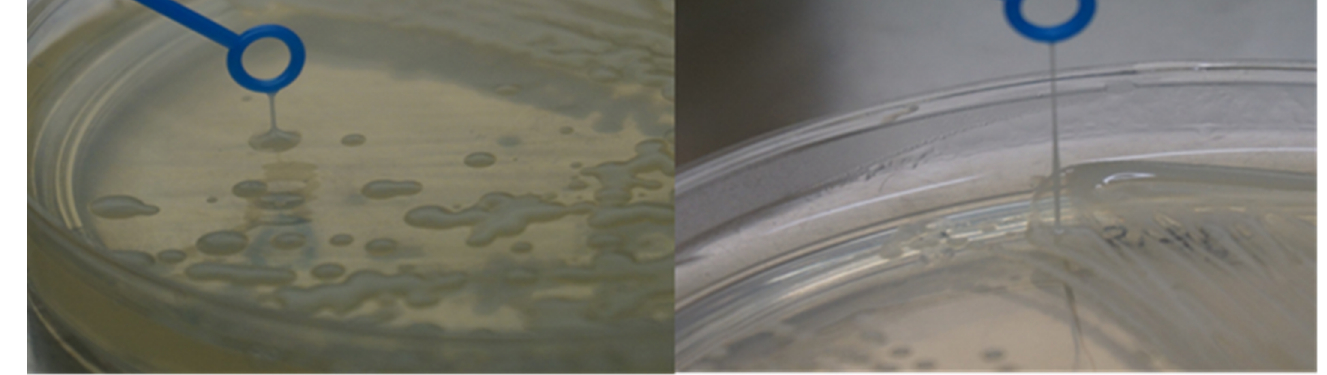
Figure 8: Mucoviscous String Production in Positive String Test Figure 8. Mucoviscous string production in positive string